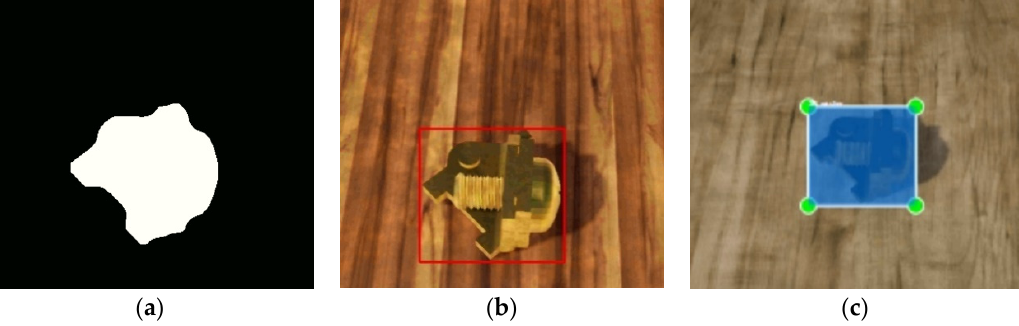
Figure 9. An autogeneration of the part localization by OpenCV for SSD: ( a ) binary threshold; ( b ) contour detection with bounding box generation; ( c ) LabelImg check of XML data generation.